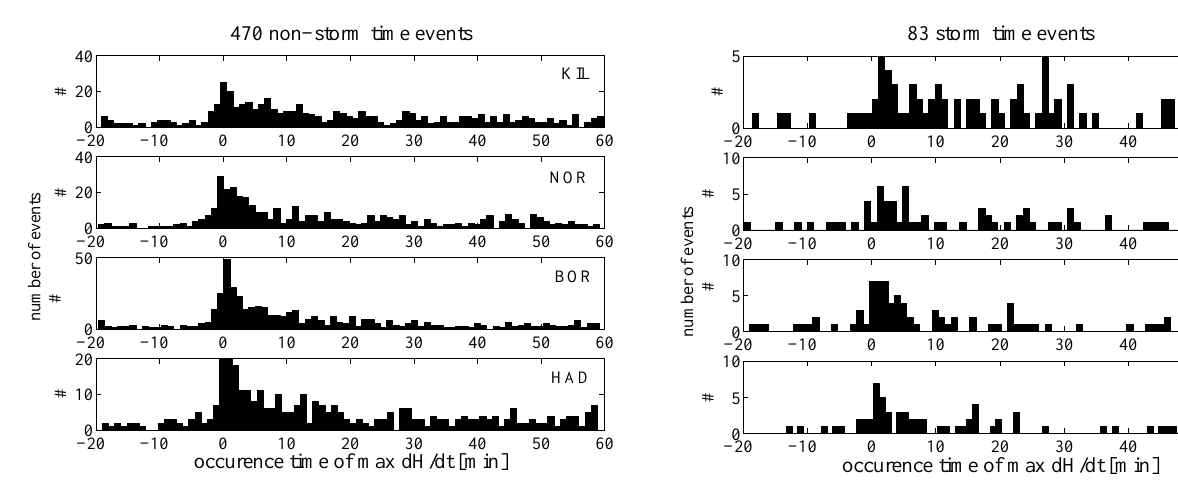
Fig. 4. Times at which max | d H /dt | occurs at SAMNET stations, KIL (Kilpisjarvi, 65.9 ◦ N), NOR (Nordii, 61.5 ◦ N), BOR (Borok, 54.11 ◦ N), HAD (Hartland, 50.99 ◦ N), during storm-time. Sub- storm onset occurs at 0min. CGM latitudes.